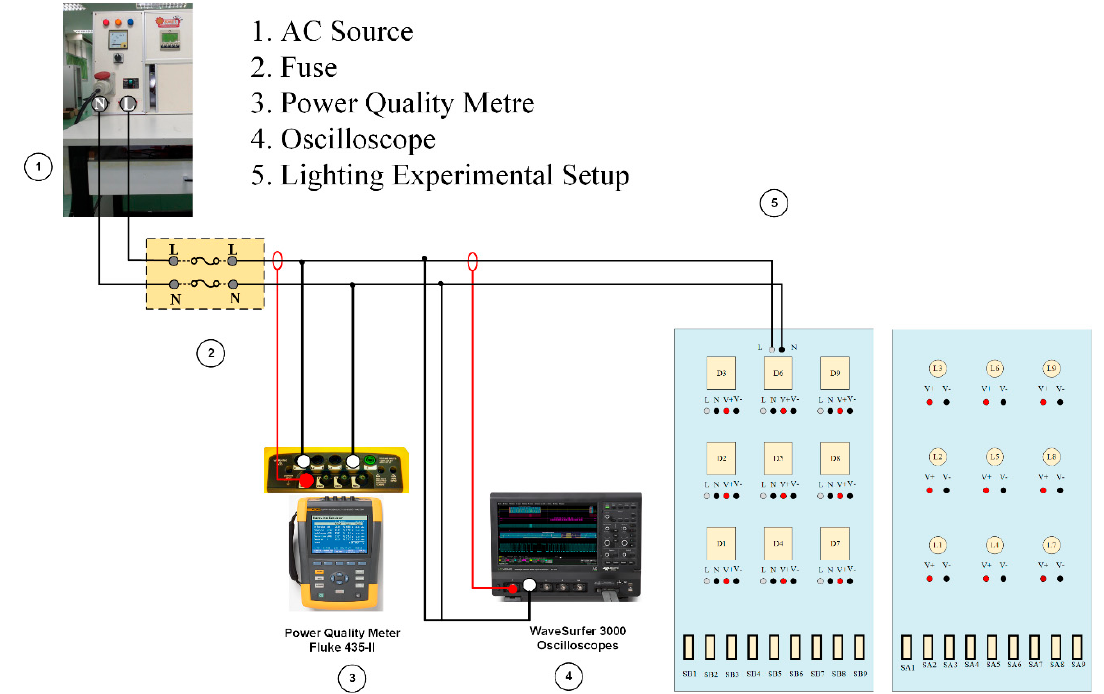
Figure 4. Overall diagram of LED lighting experimental setup.